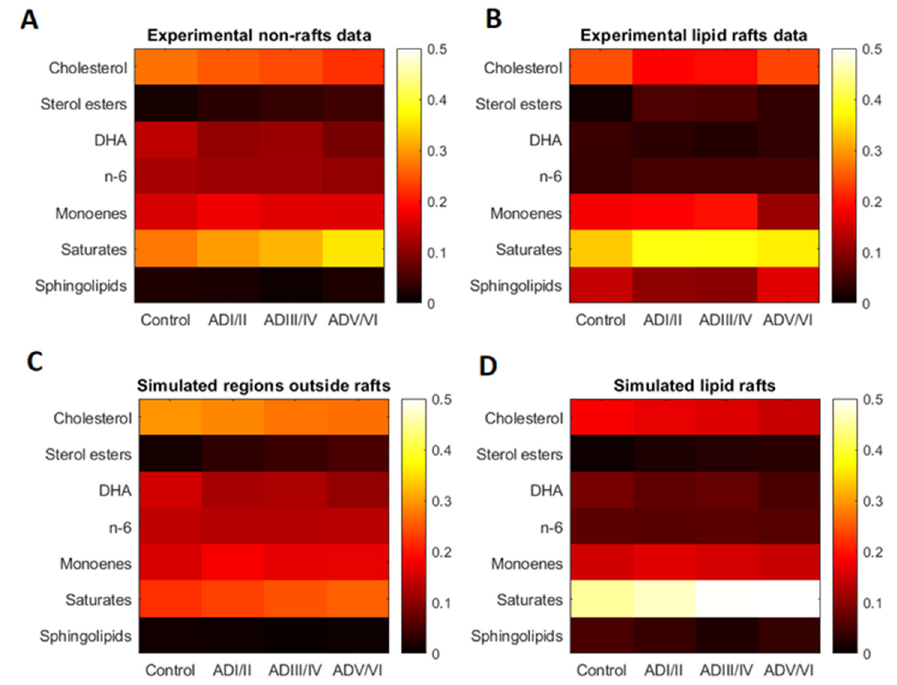
Figure 2. Lipid composition of frontal cortex non-rafts experimental data ( A ), lipid rafts experimental data ( B ), model simulation of regions outside lipid raft (non-rafts) ( D ) and model simulation of lipid raft composition ( C ). Values in color scale indicate proportions to total lipids.